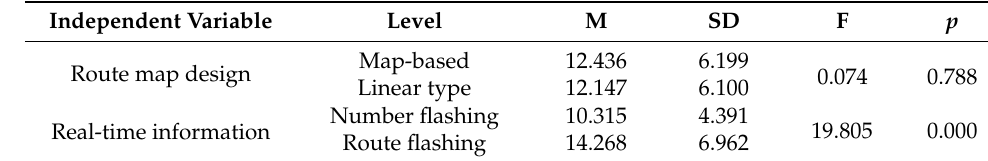
Table 2. Repeated Measures Results of Search Time.